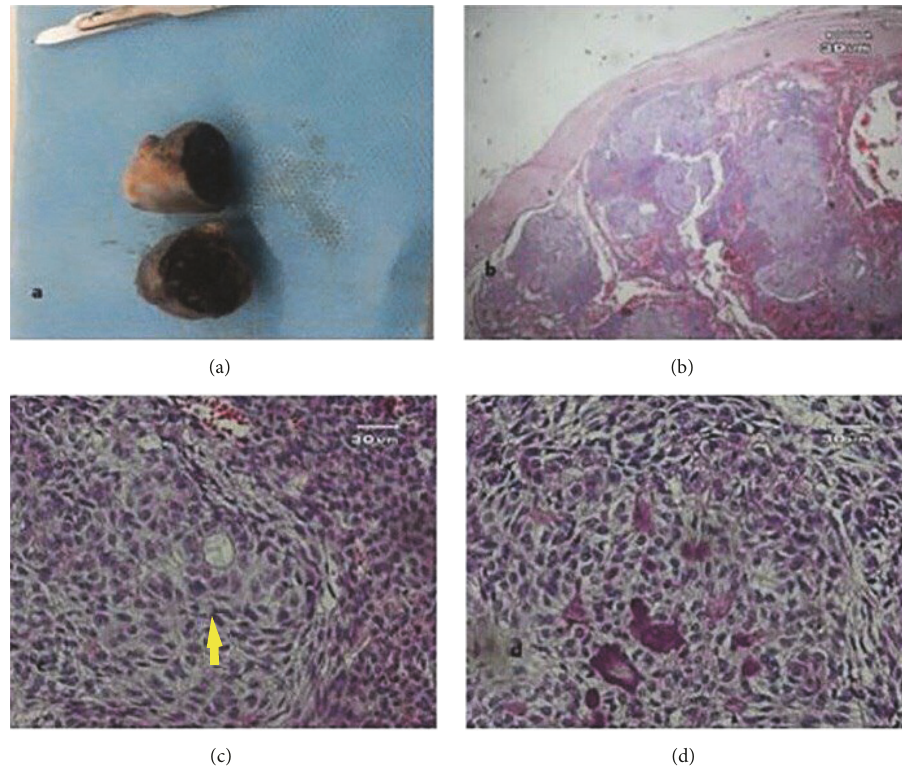
Figure 3: (a) On gross examination the lesion appears as an elliptical tissue, with 3.5 × 2.7 cm diameter. Cut section reveals a solid mass with multiple cystic spaces. (b) Low power view demonstrating a thick capsule surrounding the tumor ( × 40). (c) Duct-like structures which are the characteristic feature of AOT indicated by yellow arrow (400). (d) Spindle shaped cells that form whorled masses and rosette-like structures are noticeable ( ×